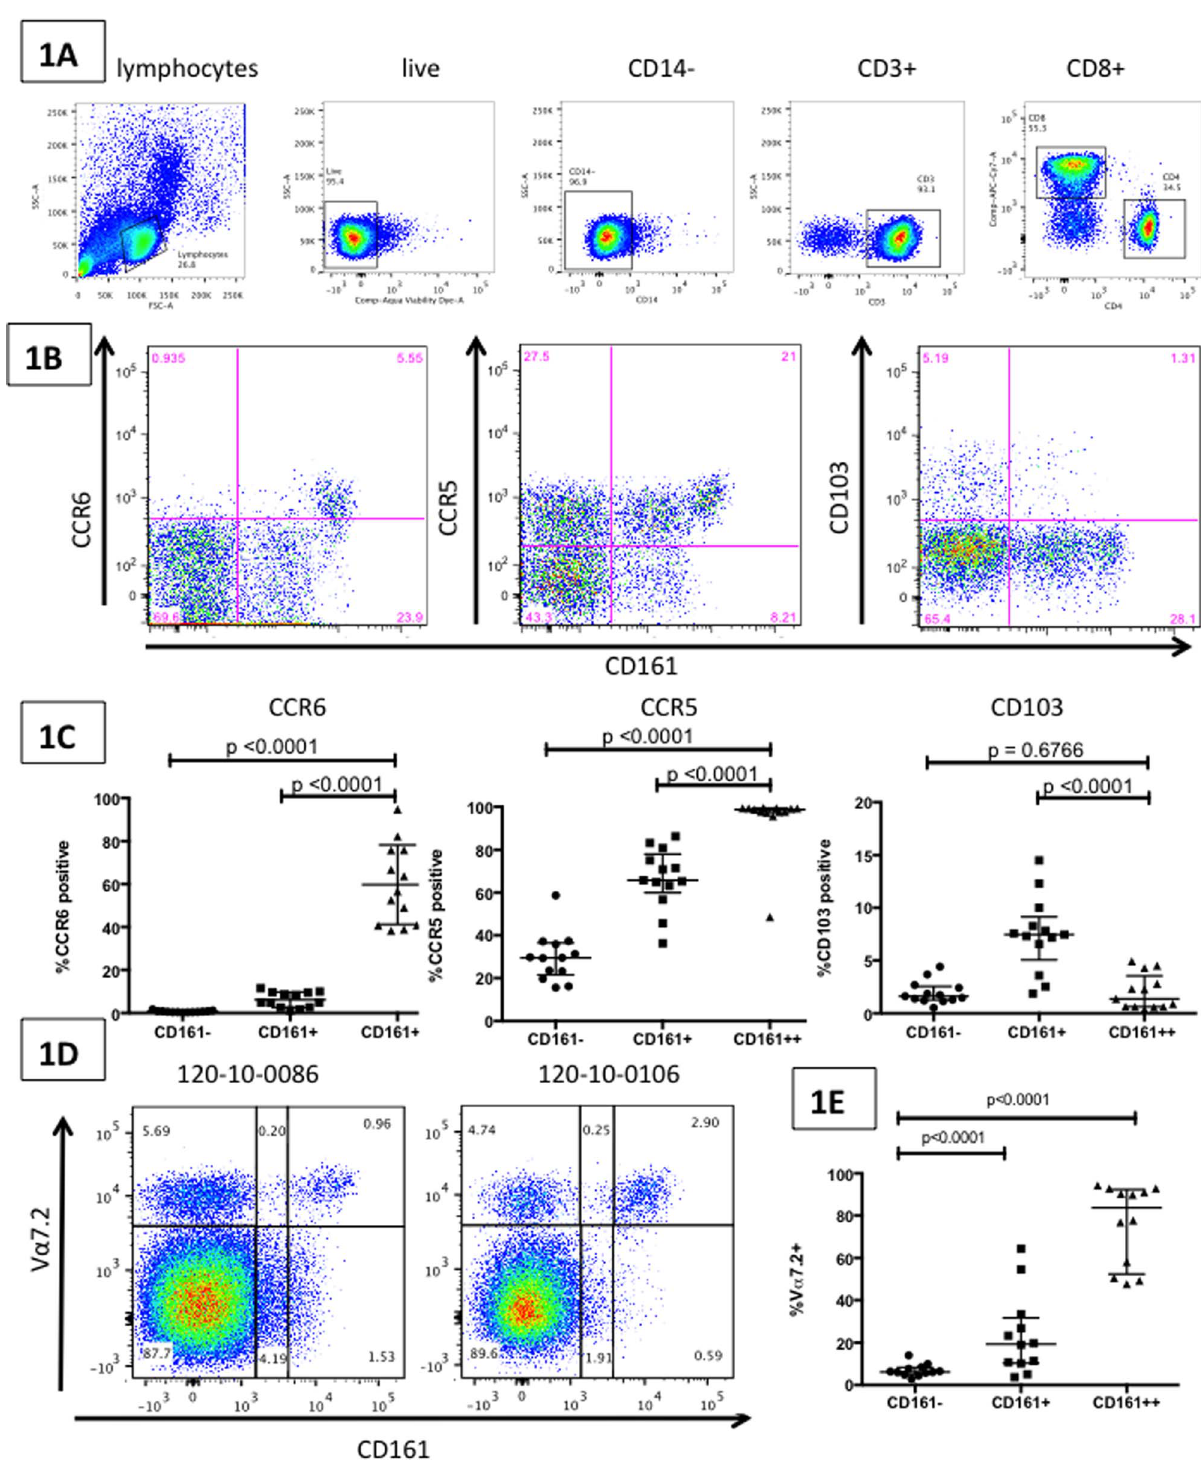
Figure 1. CD161 ++ CD8 + MAIT cells have a distinct phenotypic profile. Figure 1A: Depiction of the gating strategy used throughout: lymphocytes were selected on the basis of forward- and side-scatter characteristics, dead cells excluded, then CD14 negative, CD3 positive, CD4 negative, CD8 positive cells selected. Figure 1B: FACS plots (gated on the CD8 + T cell population) show CD161 ++ cells demonstrating high expression of CCR6 and CCR5 and low expression of CD103 in a representative example from an HIV negative TB negative subject (HNTN). Figure 1C: Aggregate data from 13 HNTN individuals demonstrate that CD161 ++ CD8 + T cells express significantly higher levels of CCR5 and CCR6 and lower levels of CD103 compared to CD161 + and CD161- CD8 + T cells. Figure 1D: FACS plots (gated on the CD8 + T cell population) show high expression of the V a 7.2 semi-invariant T-cell receptor by CD161 ++ T cells from two representative HNTN individuals. Figure 1E: Aggregate data from 12 HNTN individuals demonstrate that CD161 ++ CD8 + T cells express significantly higher levels of the V a 7.2 TCR than either CD161 + CD8 + T cells or CD161- CD8 + T cells. All graphs show median and intra-quartile range; p-values are reported for two-sided Mann-Whitney tests with threshold for significance p=0.025 after Bonferroni correction for 2 comparisons. doi:10.1371/journal.pone.0083474.g001 PLOS ONE |